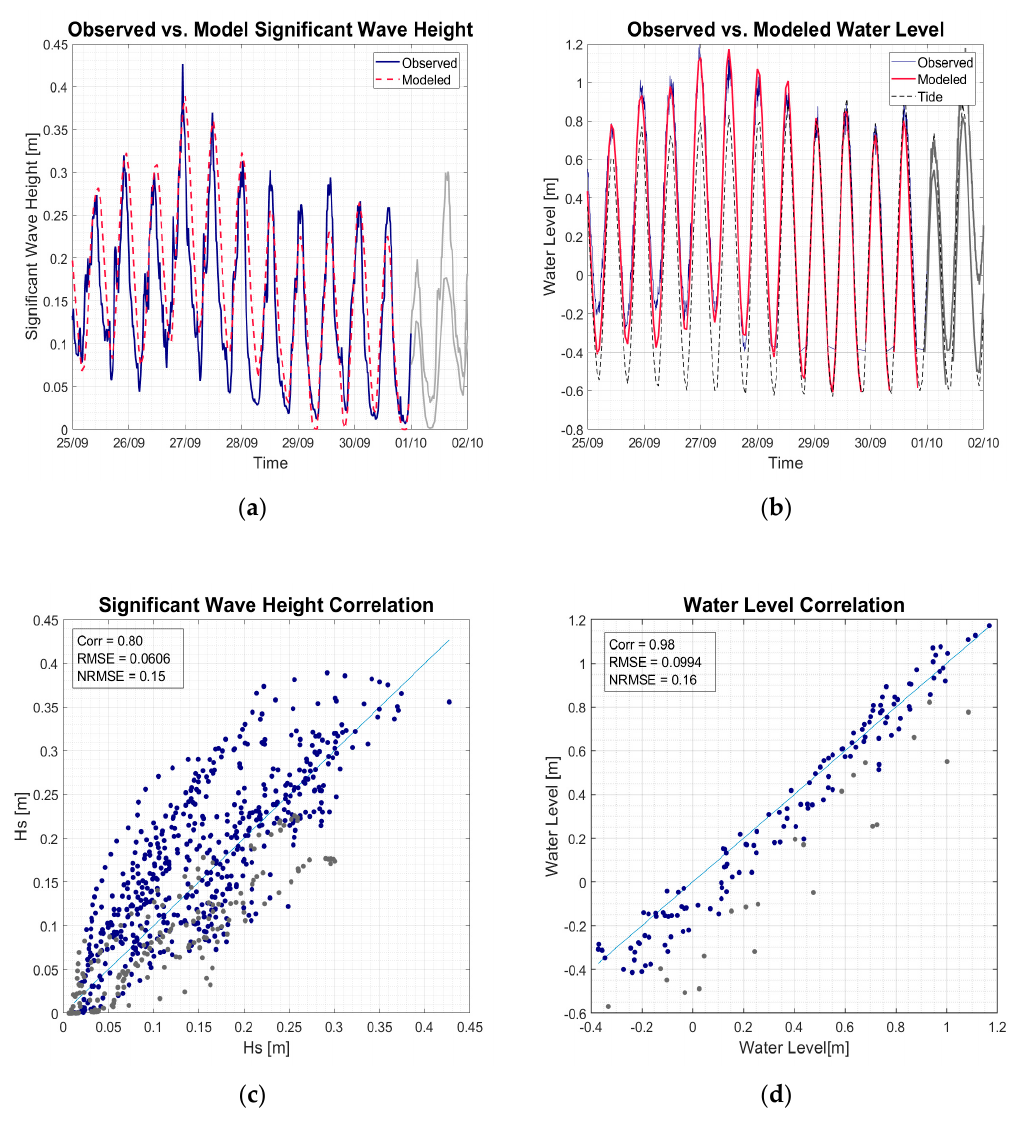
Figure 7. Significant wave height (Hs) and water level validation for the NPM against Sensor 1 (the only gauge in a non-vegetated area): ( a , b ) show the data comparison; while ( c , d ) show the correlation between the observed and modeled data. The gray portions of the data show regions of inaccuracy that were not addressed.